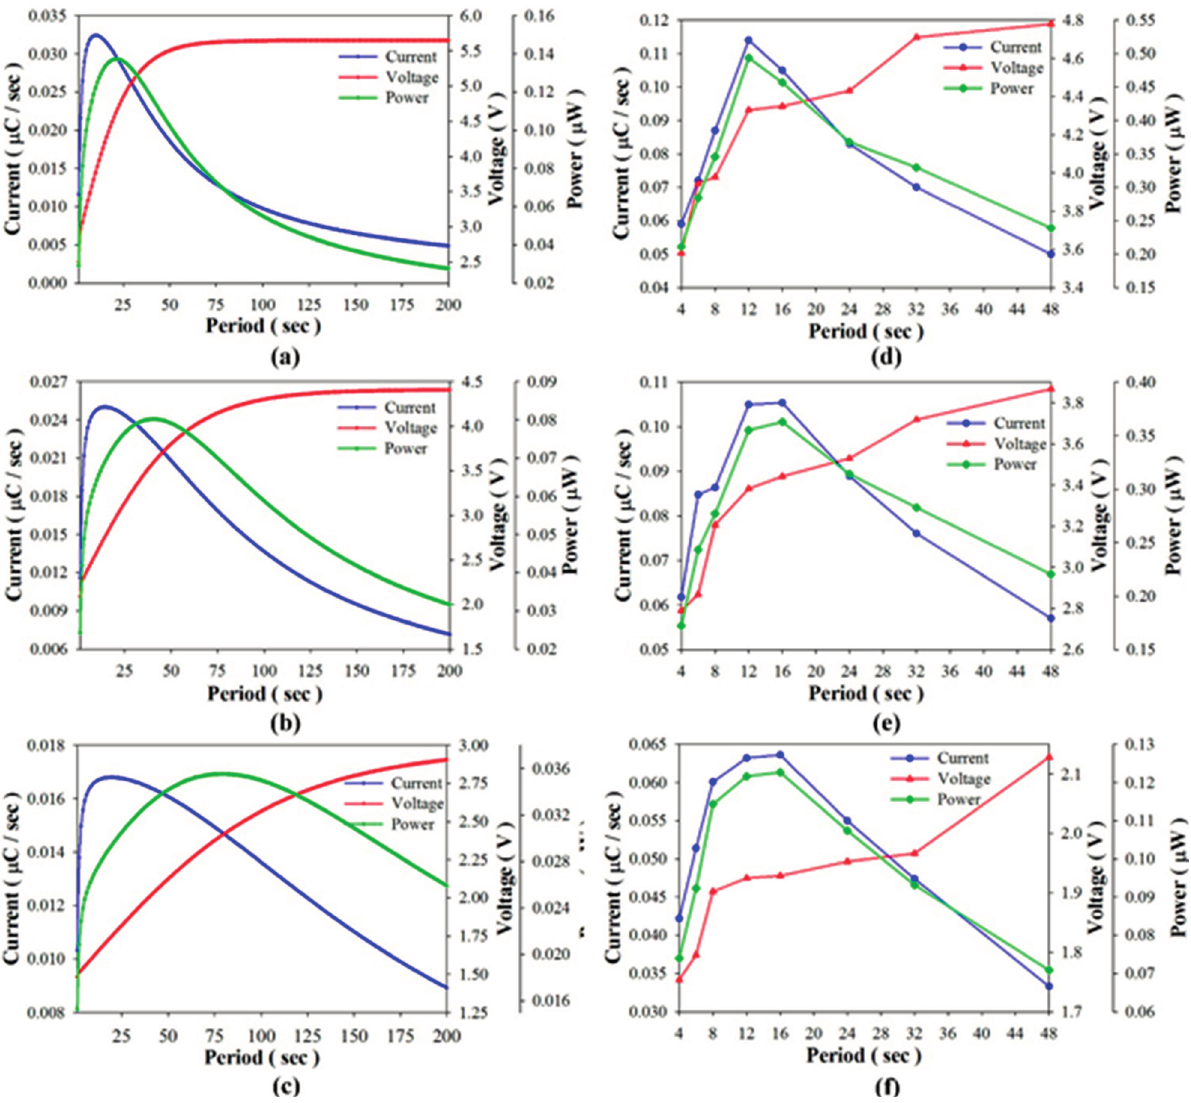
Figure 8. Harvested power, voltage and current as functions of the period when using PZT cells with thicknesses of 100 μ m ( a , d ), 200 μ m ( b , e ), and 400 μ m ( c , f ) to directly